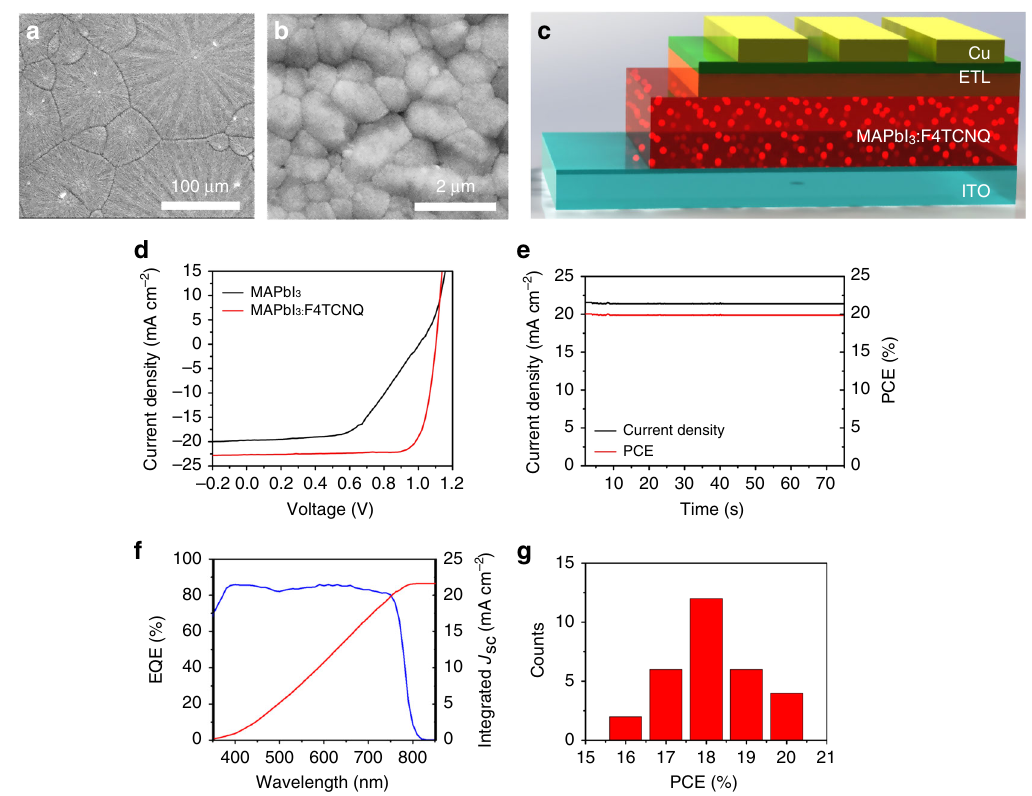
Fig. 3 Perovskite fi lm morphology, device structure, and photovoltaic performance. a Low magni fi cation and b high magni fi cation SEM images of bladed and doped MAPbI 3 fi lm prepared with MHP (0.225 wt%) and MACl (0.5 wt%) as additive, followed by co-solvents annealing treatment. c Schematic illustration of the HTL-free device con fi guration. d J – V characteristics, e Steady-state current and stabilized PCE measured at a maximum power point (0.93 V), f EQE and integrated current density, and g PCE histogram of PSCs based on MAPbI 3 :F4TCNQ fi lms (with 0.03 wt% F4TCNQ)